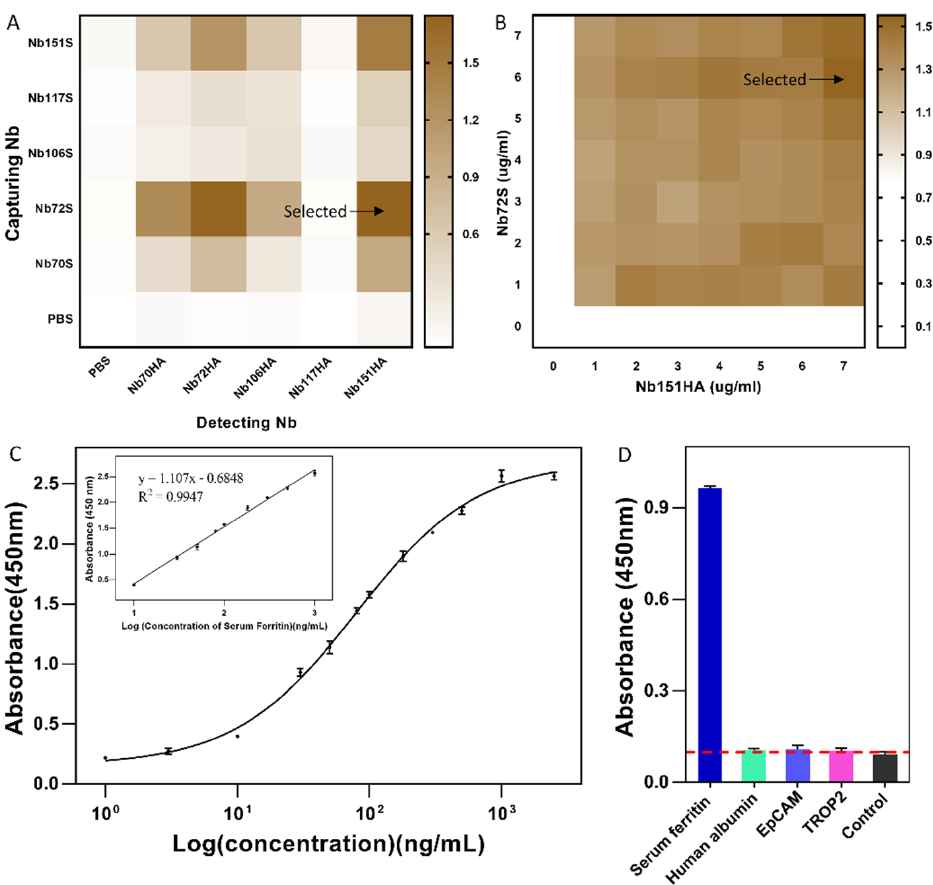
Figure 6. Establishment of an Nb-based sandwich ELISA method for SF detection. ( A ) Selection of the best performing Nb-pair to develop an immunoassay. Nb72S and Nb151HA were identified as capturing and detecting Nb, respectively. ( B ) Optimization of the concentration of capturing and detecting Nbs. In this instance, 6 µ g/mL and 7 µ g/mL were chosen for capturing Nb72S and detecting Nb151HA, respectively. ( C ) Calibration curve and the embedded linear standard curve of the developed sandwich ELISA. ( D ) Specificity and cross-reactivity of the developed sandwich ELISA. The specificity and cross-reactivity of the developed immunoassay were determined against SF, and irrelevant proteins of human albumin, EpCAM, and TROP2. The cut-off value below 0.1 was used as the threshold for the absence of cross-reactivity. All data are expressed as mean ± SD ( n = 3) and were repeated at least 3